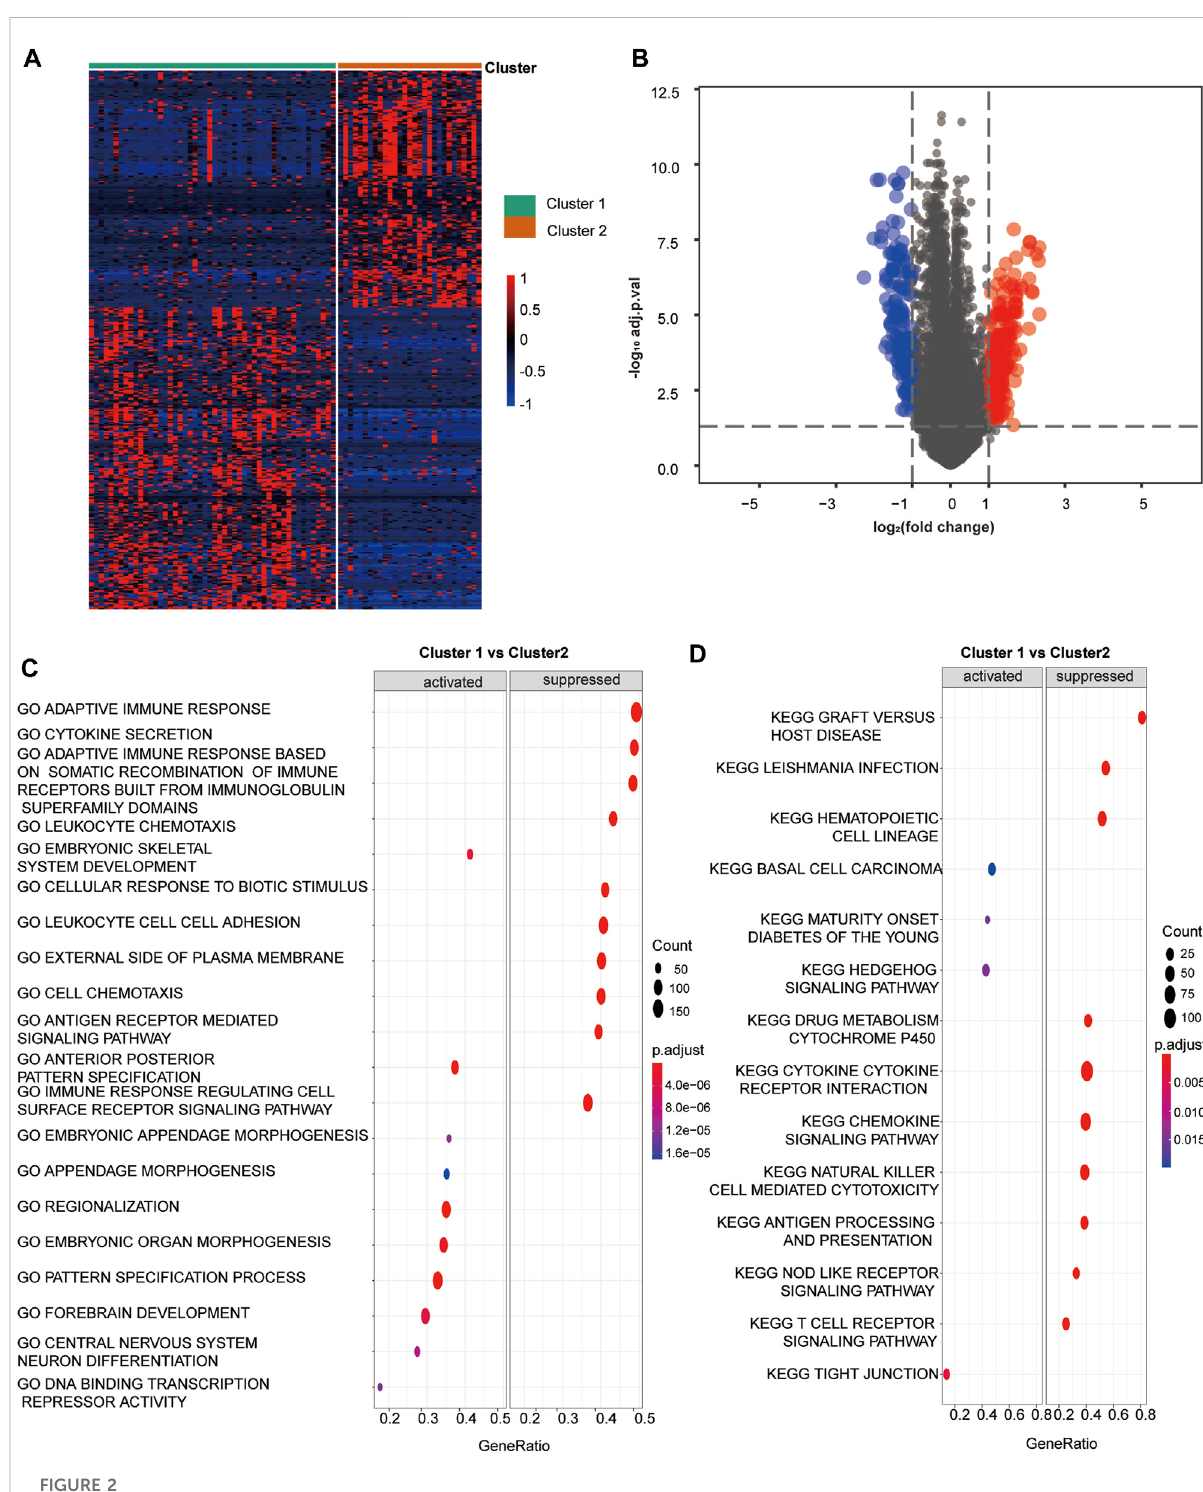
FIGURE 2 Hypoxia related DEGs and functional analysis. (A) A heatmap depicts the between DEGs cluster1 and cluster 2. Higher expression DEGs with are displayed in red, and lower expression are displayed in blue. (B) A volcano plot depicts the DEGs between cluster 1 and cluster 2. DEGs with log 2 (FC) ≥ 1wereshowninredwhilethe geneswithlog 2 (FC) ≤ -1wereshowninblue,andthegeneswith indiscriminateexpressionwereshownin gray. (C – F) GO and KEGG analysis of DEGs between cluster 1 and 2. (C) The pathway in GO functional enrichment comparison between cluster 1 and cluster 2. (D) The pathway in KEGG functional enrichment comparison between cluster 1 and cluster